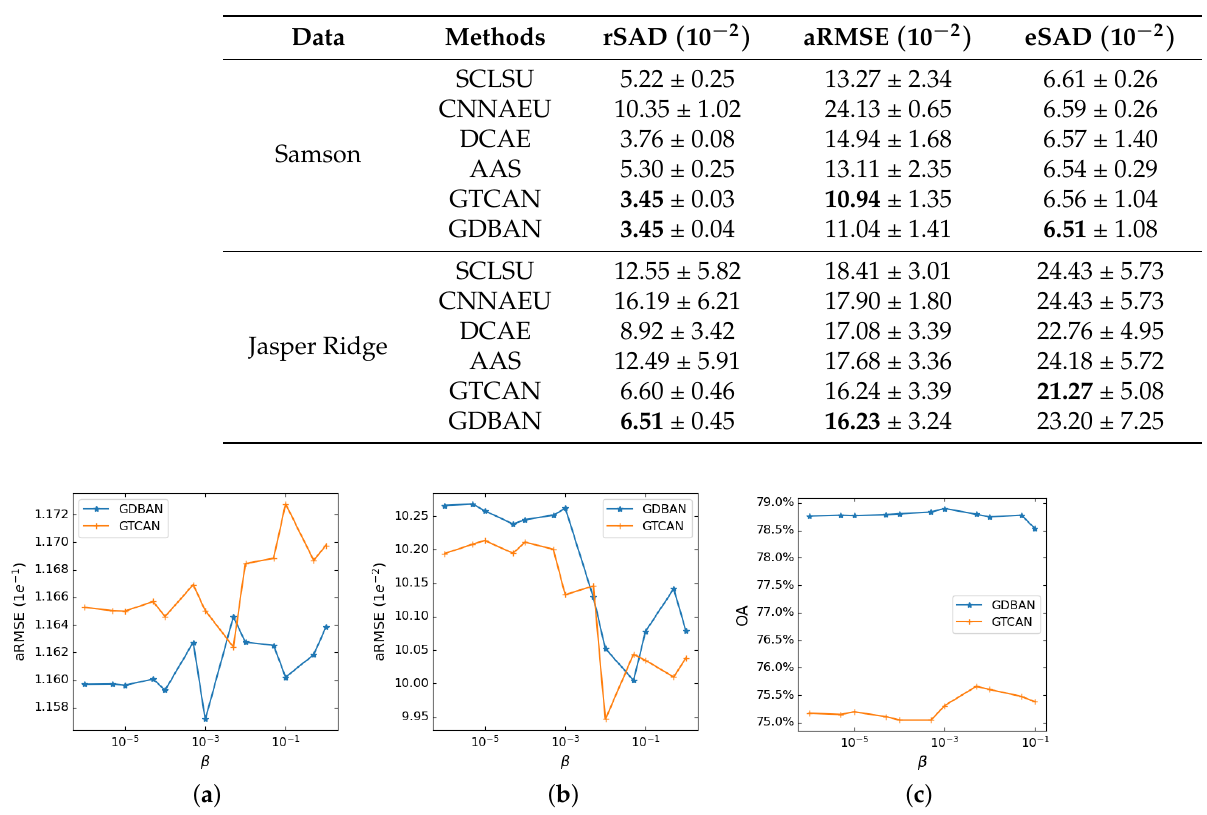
Figure 7. Parameter sensitivity analysis of gating mechanism. ( a ) Samson scene. ( b ) Jasper Ridge scene. ( c ) Houston